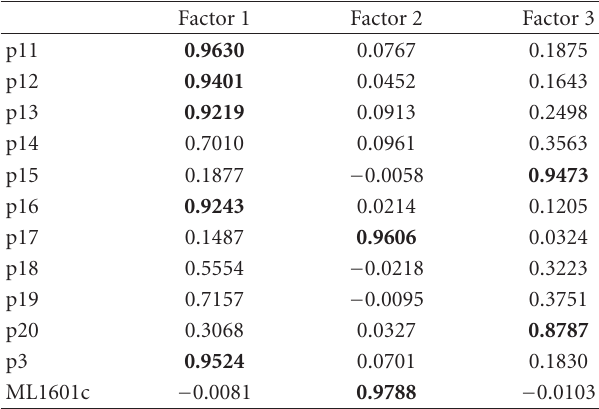
Table 2: Use of factor analysis for grouping together peptides and protein inducing similar patterns of IFN- γ responses ∗